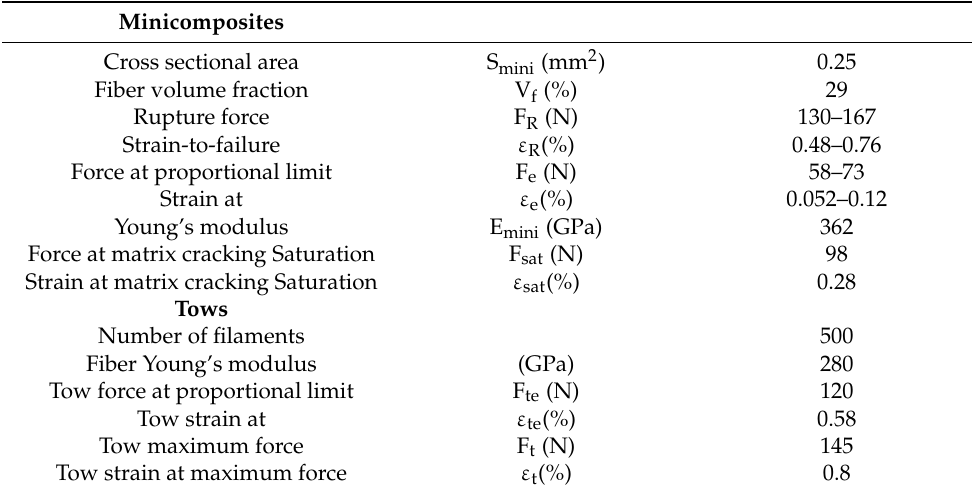
Figure 3. Tensile behavior of Hi Nicalon/SiC minicomposites at room temperature. Comparison with that of a Hi Nicalon fiber tow. Table 2. Main characteristics and tensile behavior of Hi Nicalon/PyC/SiC minicomposites and dry tows